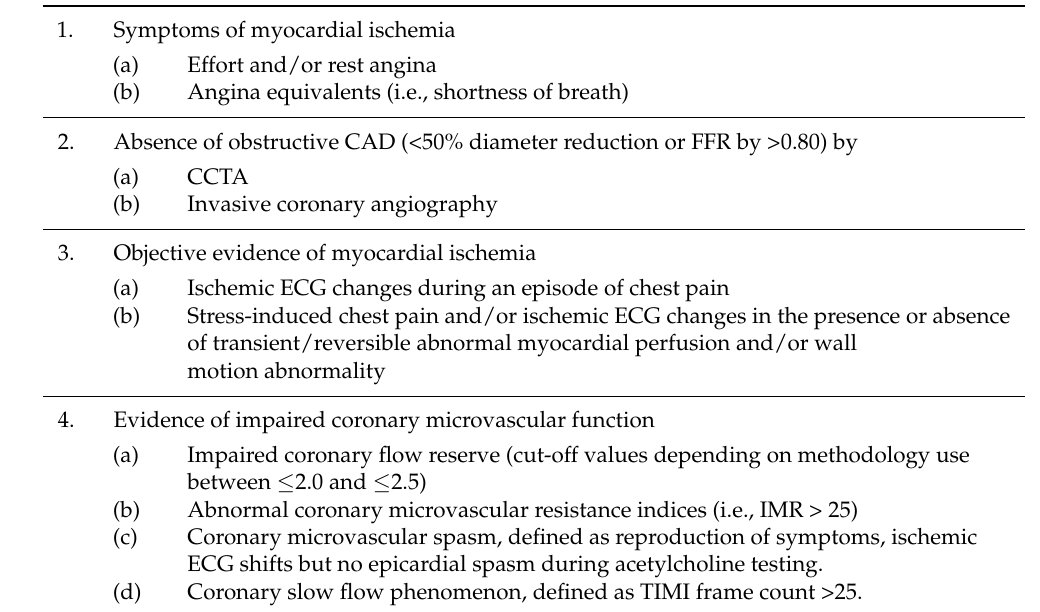
Table 3. Diagnostic criteria for the microvascular angina (MVA). Definitive MVA if all 4 criteria are present. Suspected MVA if symptoms of ischemia with no obstructive coronary artery disease are present (criteria 1 and 2) but only objective evidence of myocardial ischemia (criteria 3) or evidence of impaired coronary microvascular function (criteria 4)